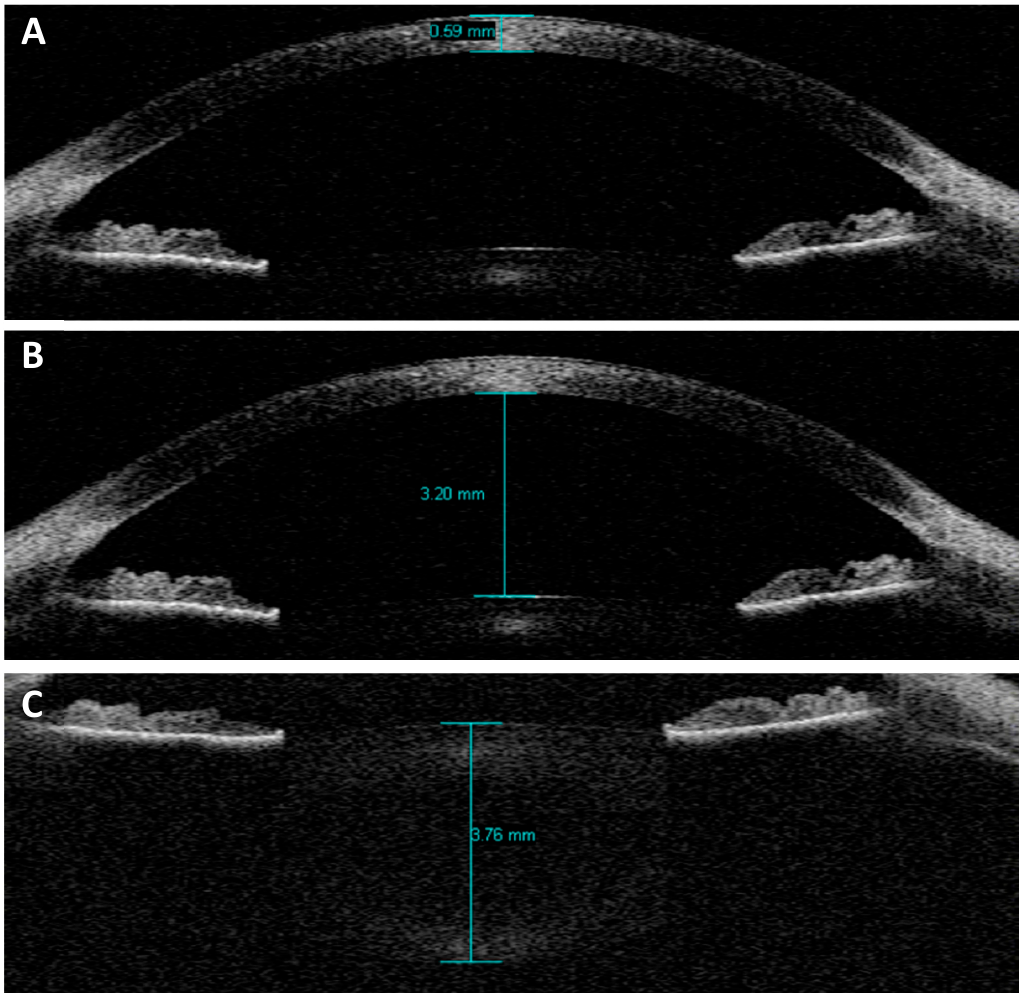
Figure 1. The Visante AS ‐ OCT screen displaying measuring calipers in situ for measurement of ( A ) corneal thickness (CT), ( B ) anterior chamber depth (ACD) and ( C ) lens thickness (LT). Images are